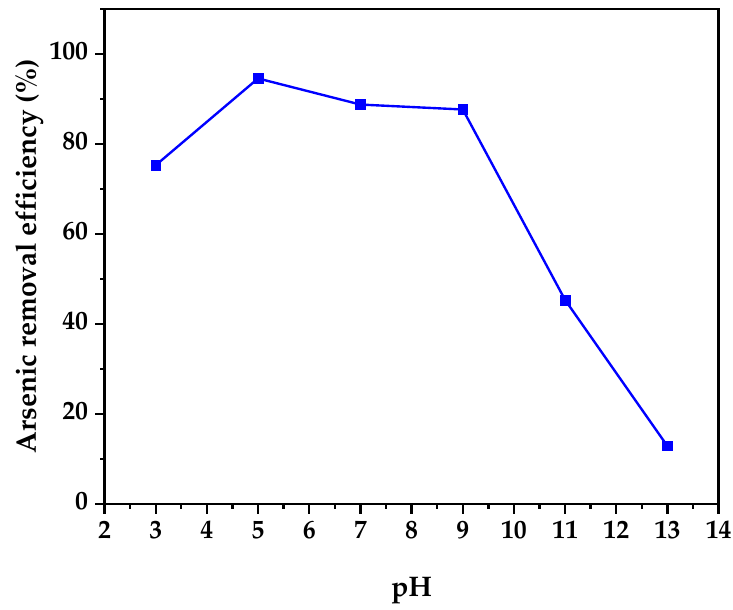
Figure 8. Effect of solution pH on arsenic removal efficiency of TiO 2 -B .